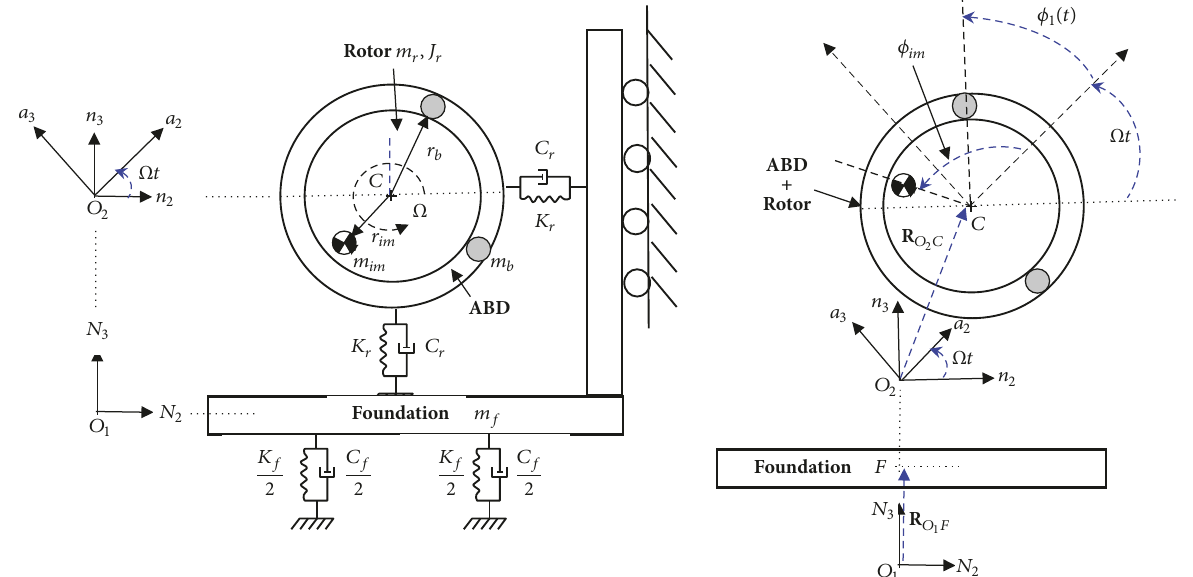
Figure 1: Coupled oscillating rotor/ABD system with flexible foundation and the corresponding degree-of-freedom coordinates.